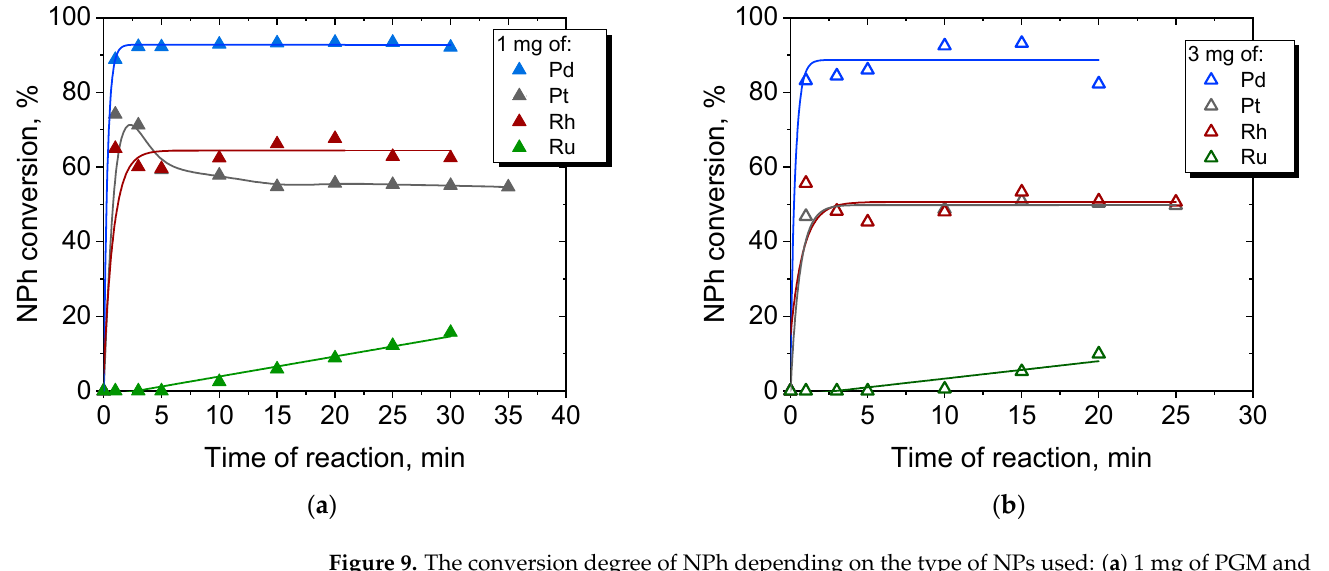
Figure 9. The conversion degree of NPh depending on the type of NPs used: ( a ) 1 mg of PGM and ( b ) 3 mg of PGM.